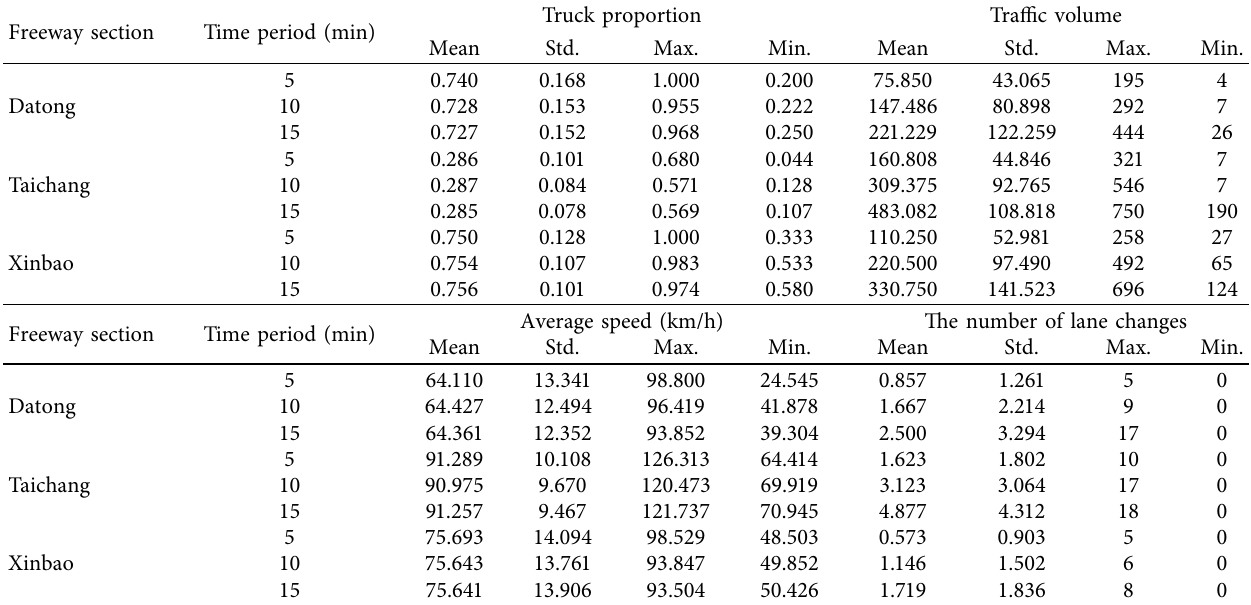
Table 1: The range of basic data collected from different time periods and